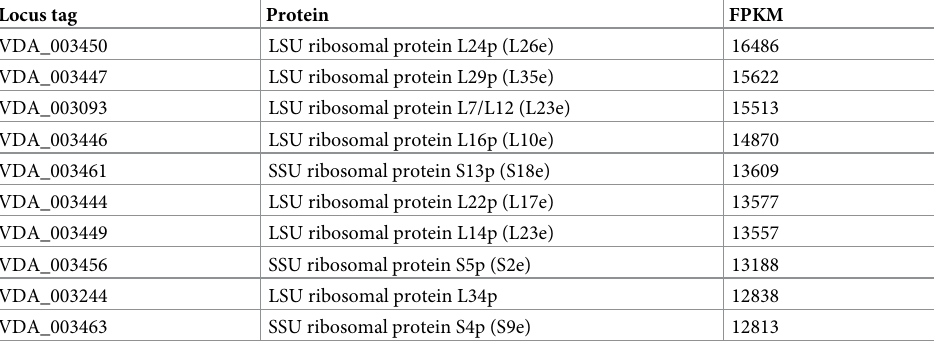
Table 4. List of most expressed genes at 25˚C and their corresponding FPKM values. FPKM values shown corre- spond to mean values of the three biological replicates.